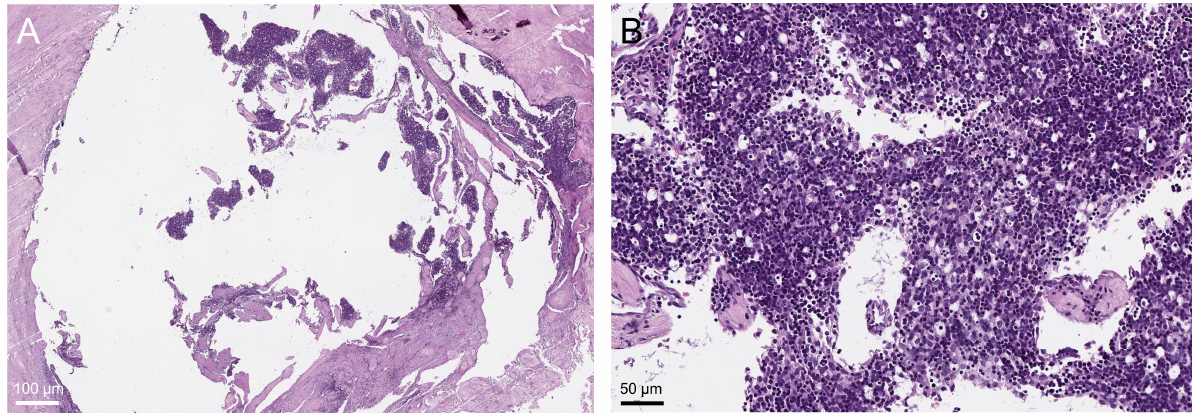
Figure 4. Pseudocystic B2-thymoma showing impressive regressive changes, sclerosing, and inflam- matory infiltration ( A ) but also a circumscribed clear B2-thymoma area ( B ). Two other cases did not cluster in the histologically anticipated MC group. Both cases (249832 and 249834) were AB-thymomas that clustered with the MC-A cohort. Retrospective histological re-analysis of these “type A-like” cases showed a very low lymphocyte content, making A-thymoma a reasonable differential diagnosis (Figure